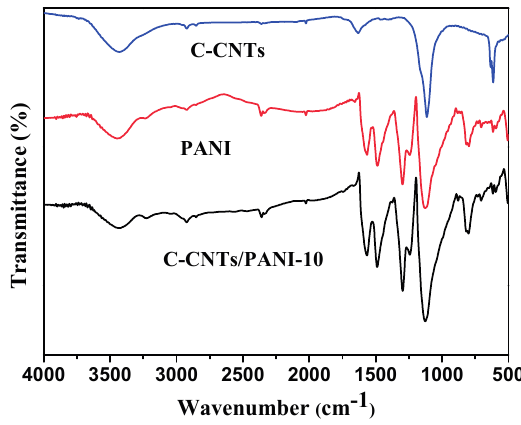
Figure 1. Fourier transform infrared (FT-IR) spectra of the C-CNTs, pure PANI, and the C-CNTs/PANI-10 composite.